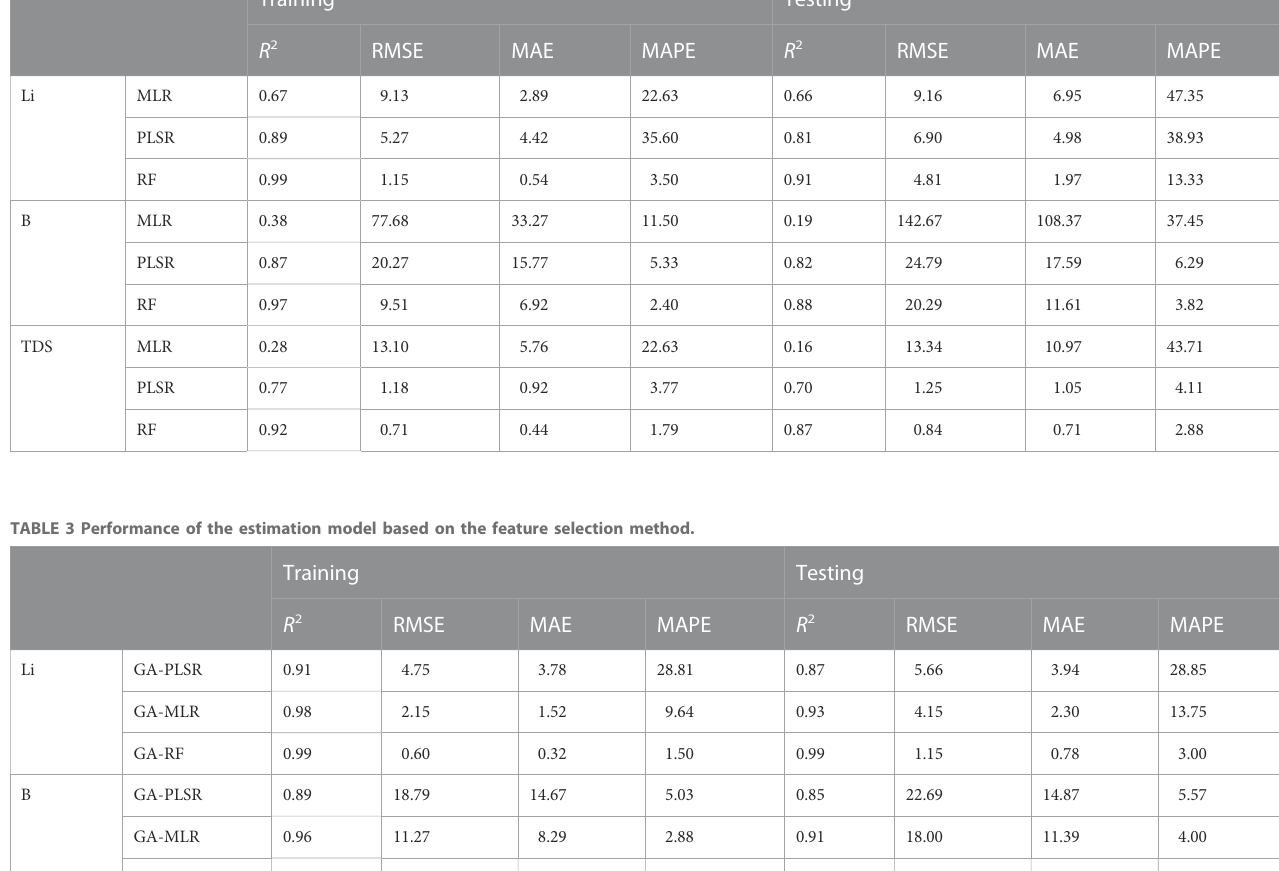
TABLE 2 Results of estimation models based on all spectral bands. Training